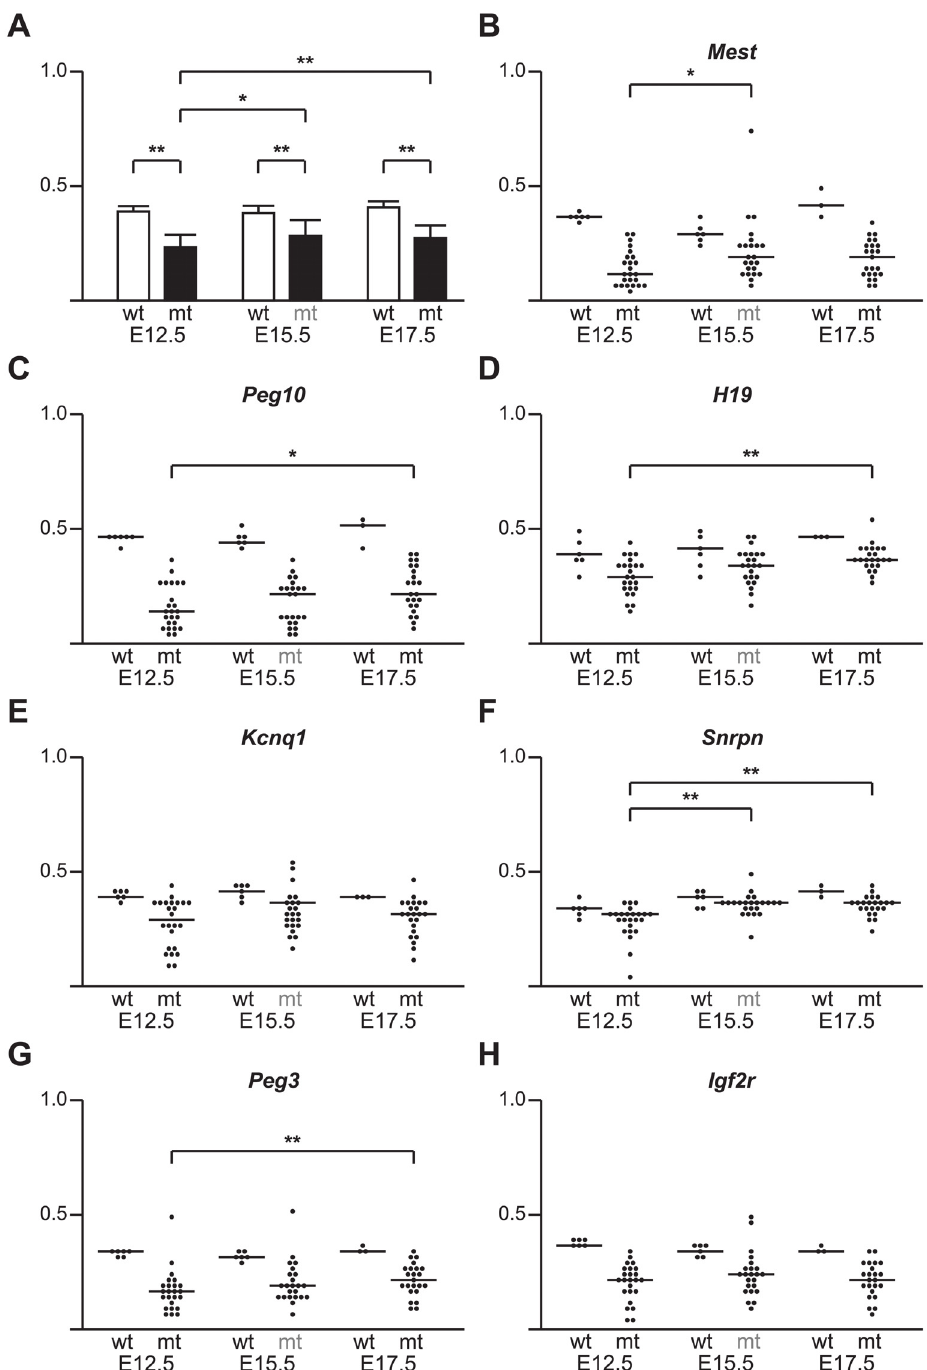
Fig 1. Imprinted gDMD methylation levels in wild-type (wt) and DNMT1o-deficient (mt) placentas across mid gestation (E12.5, E15.5 and E17.5). (A) Bar graphs showing average mean and standard deviation of total imprinted gDMD methylation of wt (open bars) and mt (filled bars) across mid-gestation. (B-F) Binned scatter plot showing individual wt and mt placentas across mid-gestation and the sample mean for the following imprinted gDMDs: (B) Mest , (C) Peg10 , (D) H19 , (E) Kcnq1 , (F) Snrpn , (G) Peg3 and (H) Igf2r . Small brackets indicate significant differences between gestational age matched sample populations of wt and mt gDMD methylation medians. Larger brackets indicate significant differences between mutant gDMD methylation medians at different gestational ages. * (P < 0.01), and ** (P < 0.001) denote significant differences of mutant median imprinted gDMD methylation compared to wild type, or between gestational ages of mutant sample population by the Rank-sum